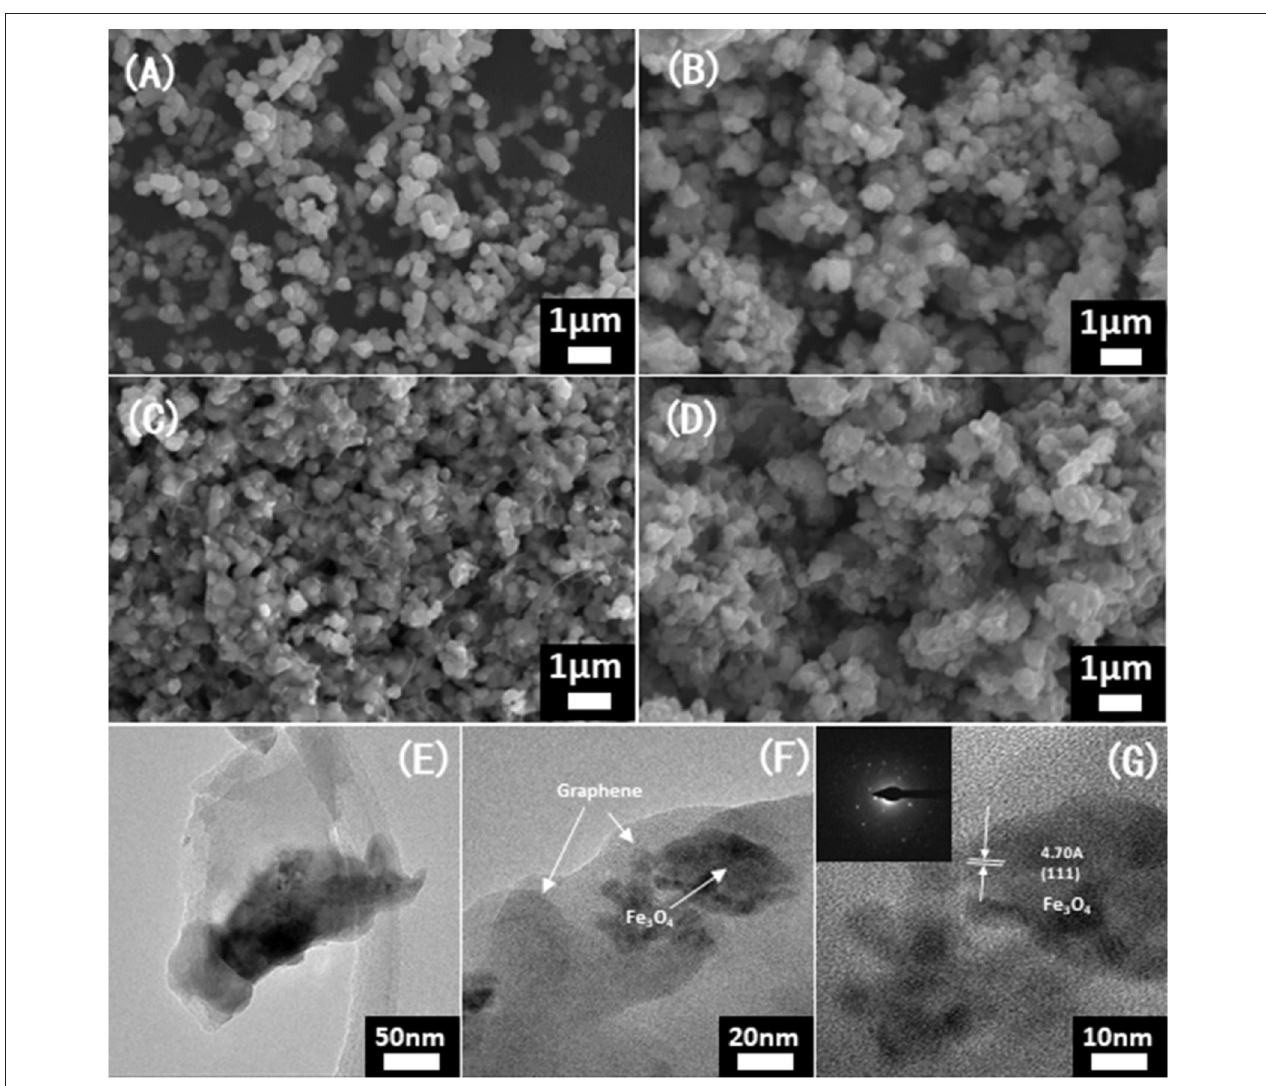
FIGURE 2 | SEM images of (A) the initial state for purchased Fe 2 O 3 particles, (B) Fe 3 O 4 @G-500, (C) Fe 3 O 4 @G-600, and (D) Fe 3 O 4 @G-700. (E–G) TEM images and ( G inset) SAED patterns of Fe 3 O 4 @G-600.